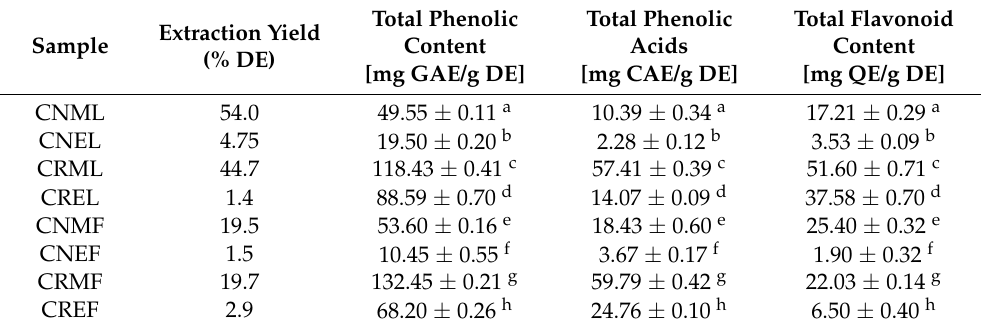
Table 1. The total content of phenolic (TPC), flavonoid (TFC), and phenolic acids (TPAC) in the leaves and fruits of C. nebrodensis and C. roesus